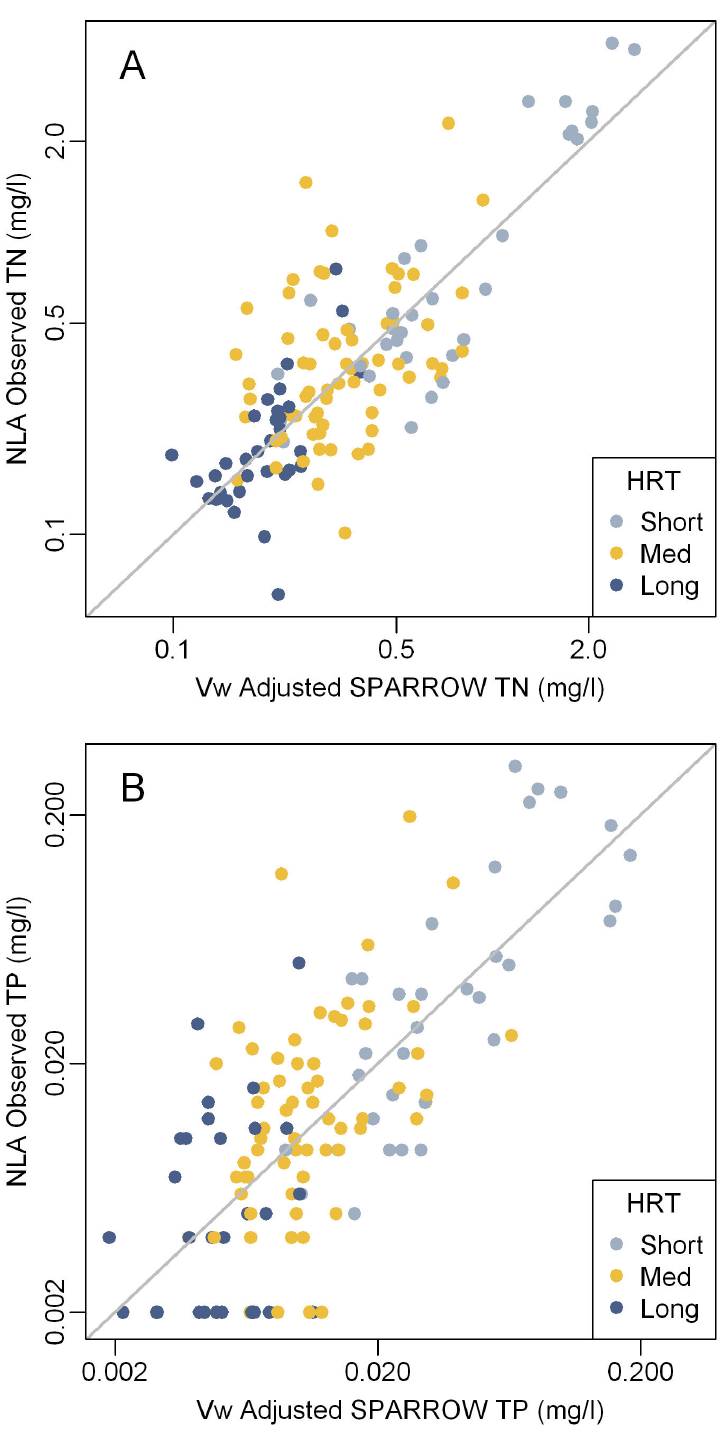
Figure 4. Adjusted (Vollenweider Model) total nitrogen (A) and phosphorus (B) in Northeast Lakes. National Lake Assessment observed 2007 summer concentrations of (A) total nitrogen and (B) phosphorus in Northeast Lakes versus the Vollenweider (Vw) adjusted average annual SPARROW predicted concentrations. Robust non-linear regression was used to fit SPARROW predictions to 2007 NLA observations using the Vollenweider equation (H residence time (HRT: Short < 0.04 years; Medium = 0.04 to 0.4 years; Long > 0.4 years). TN = Total Nitrogen. TP = Total Phosphorus. doi: 10.1371/journal.pone.0081457.g004 PLOS ONE |